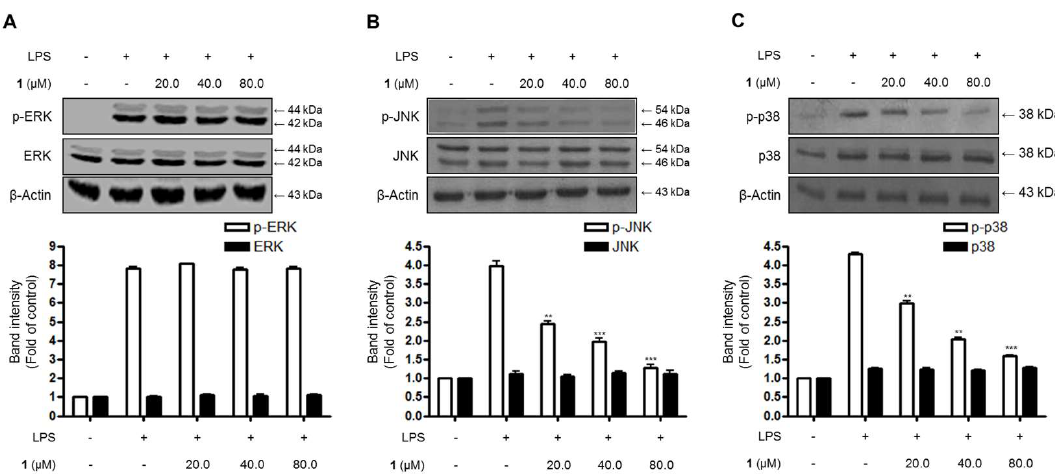
Figure 6. Figure 6. The effects of steppogenin ( 1 ) on extracellular signal–regulated kinase (ERK) ( A ), c-Jun N-terminal kinase (JNK) ( B ), and p38 ( C ) MAPK phosphorylation and protein expression. ( A – C ) The cells were pretreated for 3 h with the indicated concentrations of 1 and stimulated for 1 h with LPS (1 μg/mL). The levels of phosphorylated ERK (p-ERK), phosphorylated JNK (p-JNK), and phosphorylated-p38 MAPK (p-p38 MAPK) were determined by western blot analysis. Representative blots from three independent experiments with similar results and densitometric evaluations are shown. The band intensities were quantified by densitometry and normalized to the density of the β-actin band; the normalized values are presented below each band.